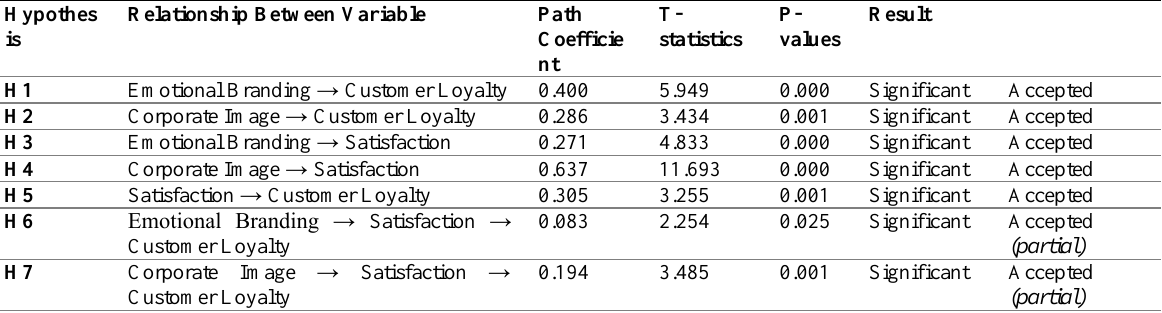
Table 2: Hypothesis Testing